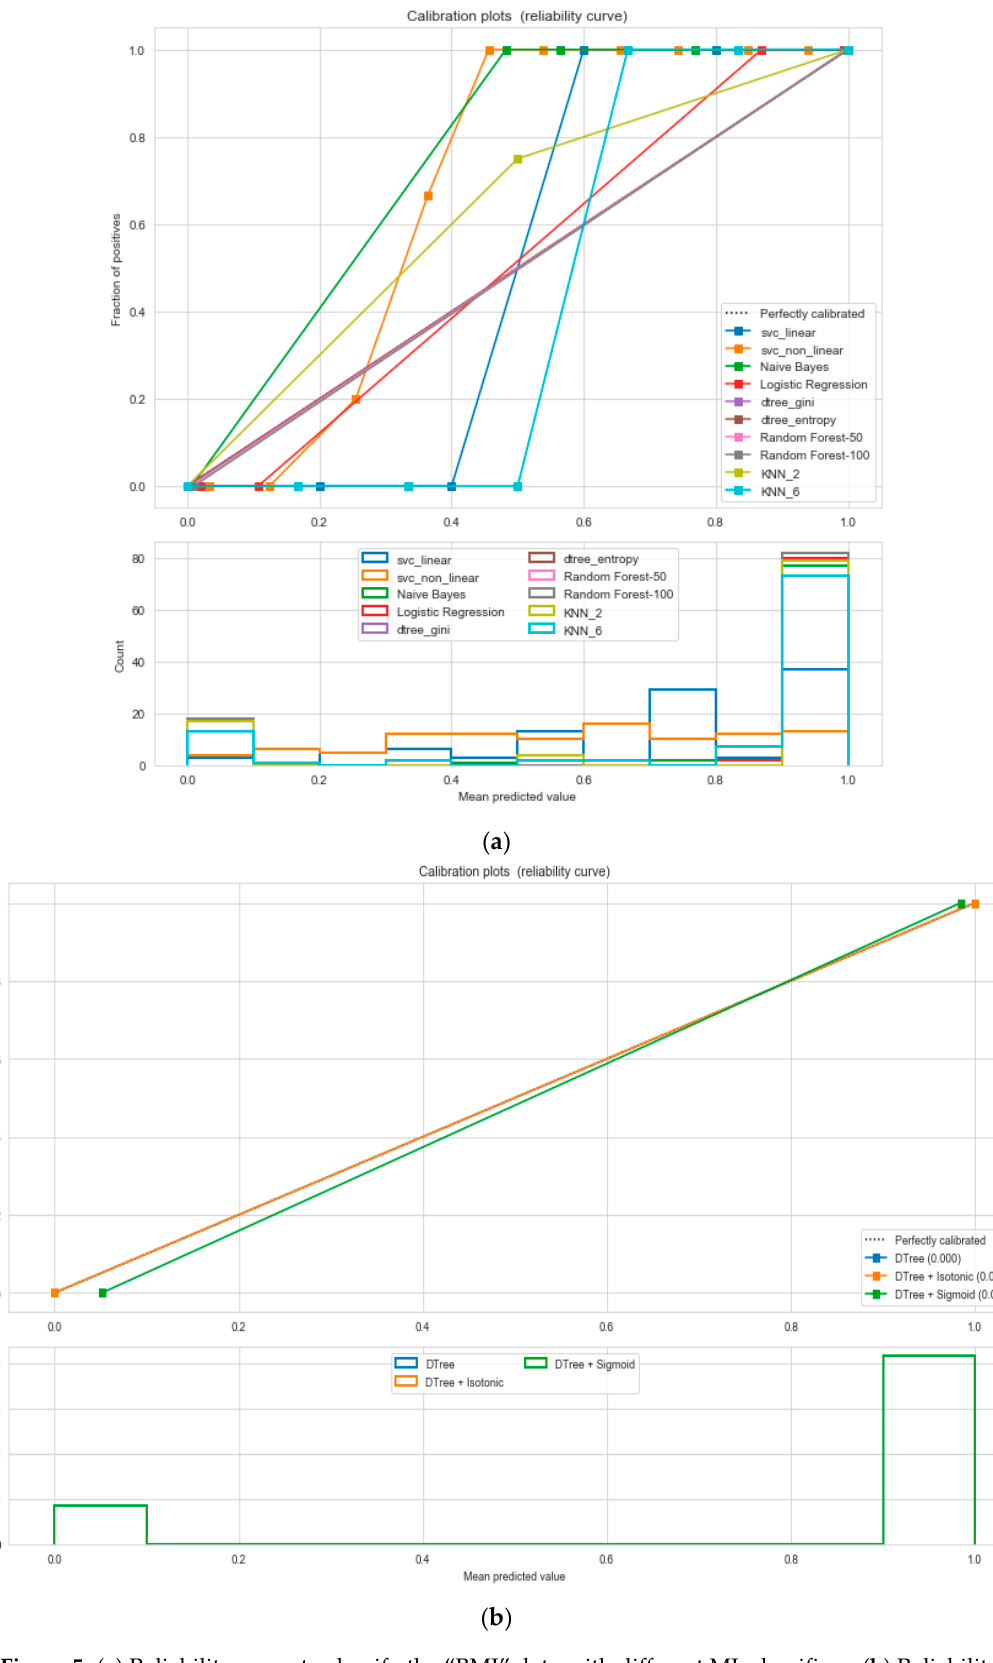
Figure 5. ( a ) Reliability curve to classify the “BMI” data with different ML classifiers. ( b ) Reliability curve to classify the “BMI” data with “Calibrated Decision Tree”.